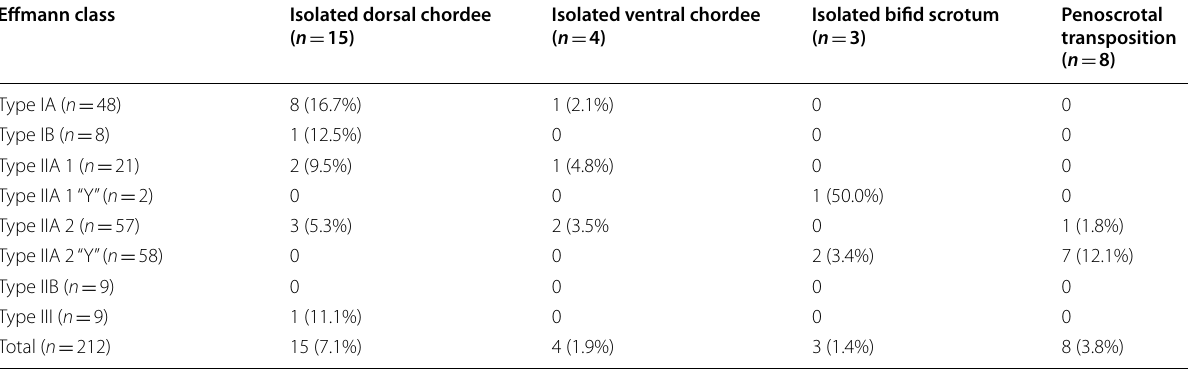
Table 2 Frequency distribution of reported defects of the external genitalia according to Effmann class in